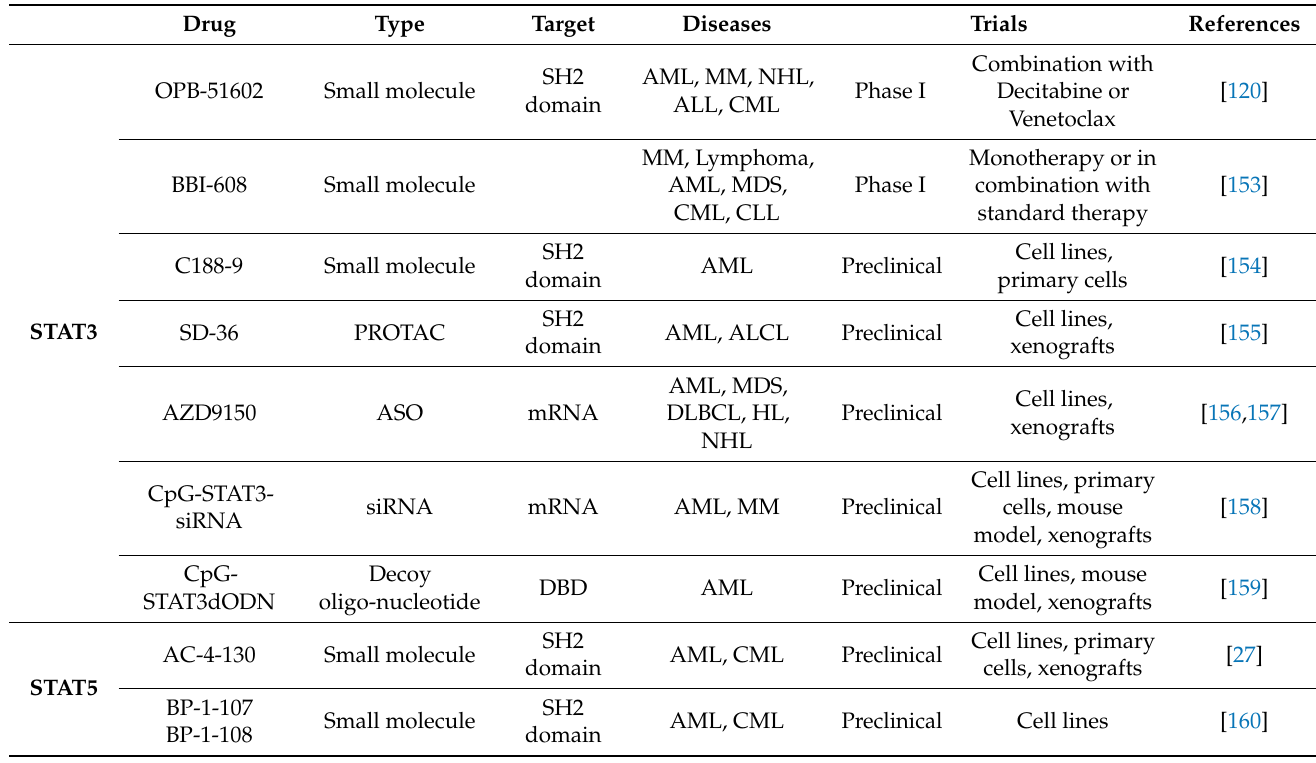
Table 2. STAT inhibitors investigated in